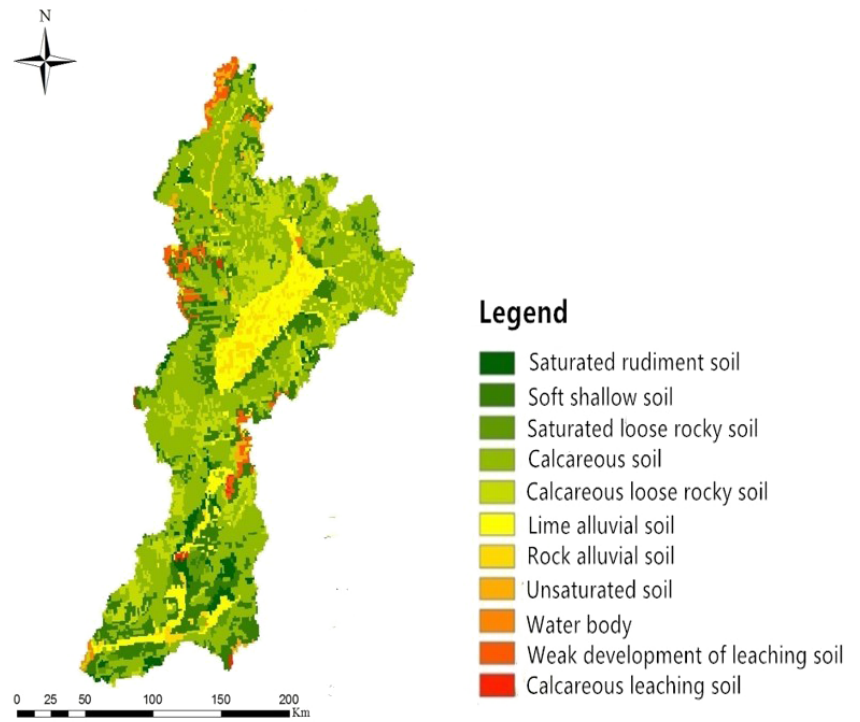
Figure 3. Distribution of Soil Types in Fenhe River